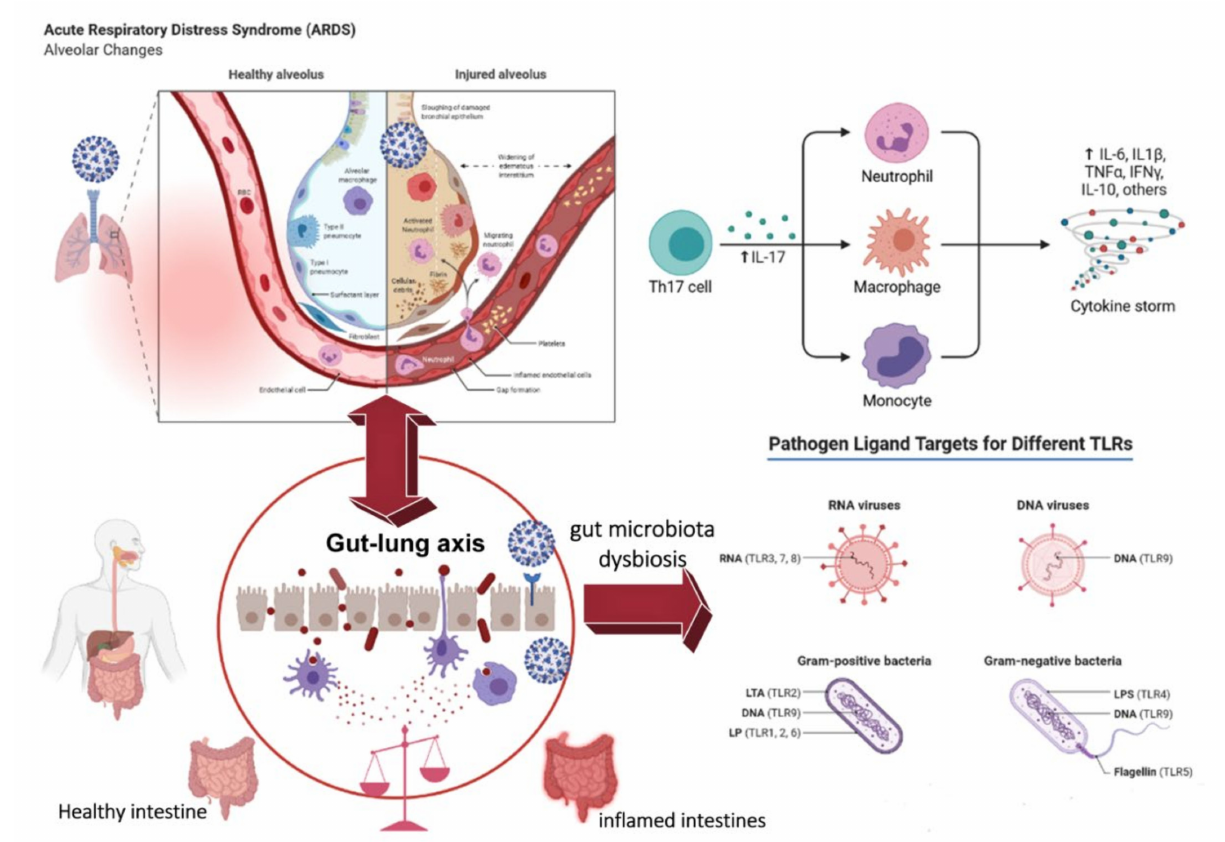
Figure 3. The gut–lung axis in